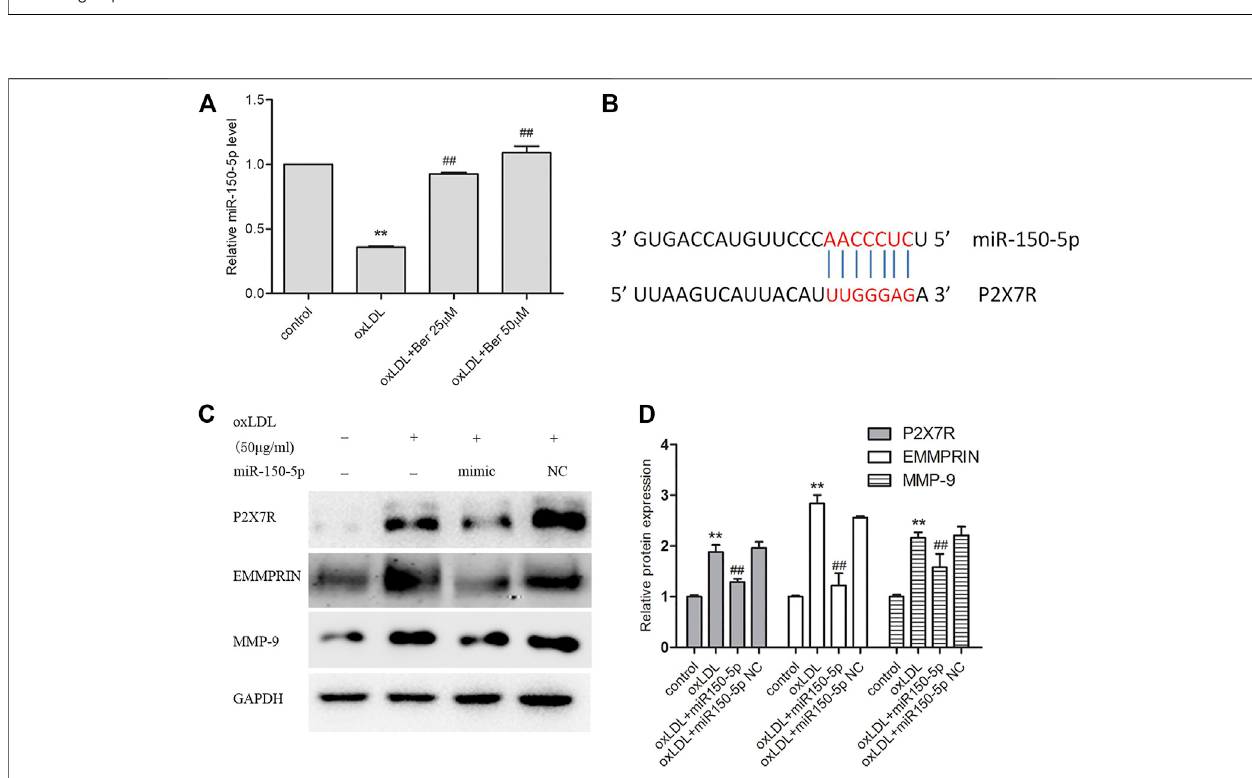
FIGURE 6 | Berbeine upregulated miR-150-5p expression (A) ; P2X7R and miR-150 have strong binding sites at their 3 ′ -UTRs. MiR-150 seed pairing in the target regions P2X7R is shown as red vertical lines (B) ; (C) overexpression miR-150-5p repressed P2X7R as well as EMMPRIN, MMP-9. Densitometry measurements of P2X7R, EMMPRIN, and MMP-9 were normalized to GAPDH. The band densities were measured by Quantity One 1D analysis software. The data (means ± SD) were obtained from three independent experiments. ** p < 0.01 compared with Control, #: p < 0.05, ##: p < 0.01 compared with the oxLDL group.